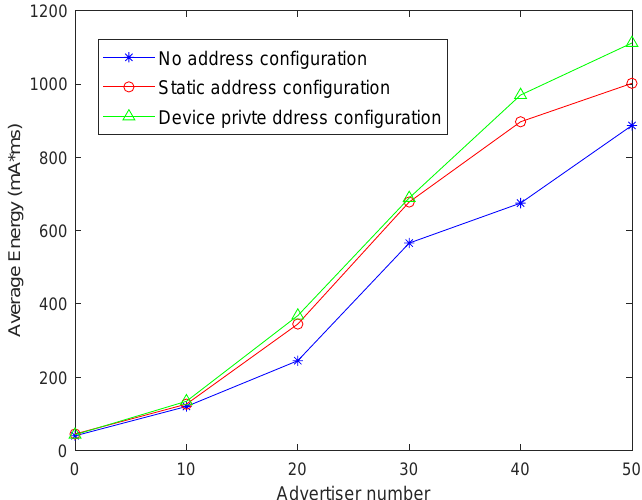
Figure 8. The average energy respect to the advertiser